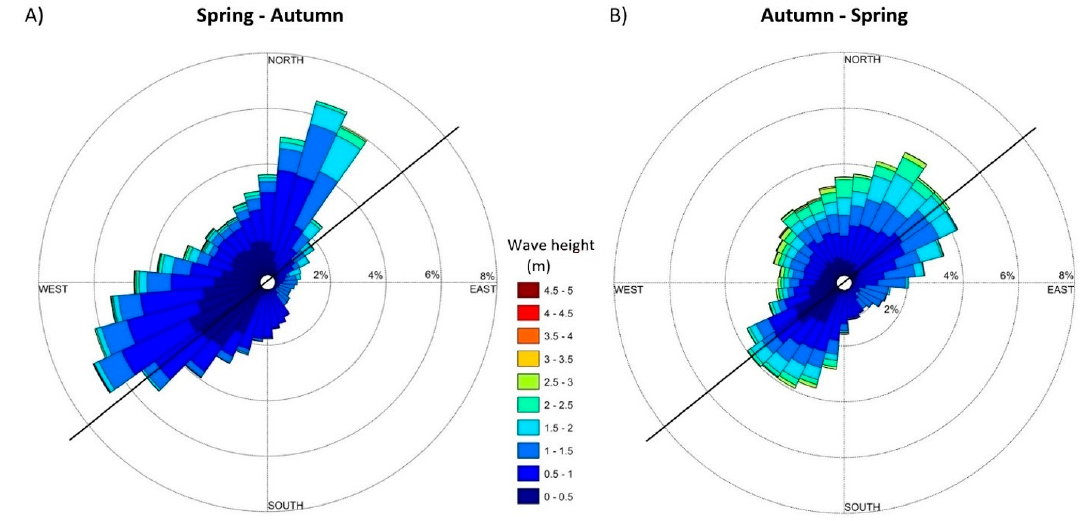
Figure 2. O ff shore wave roses from 2013 to 2019: ( A ) spring to autumn (from 15 April–14 October), ( B ) autumn to spring (from 15 October–14 April). Black lines correspond to the coastline orientation.